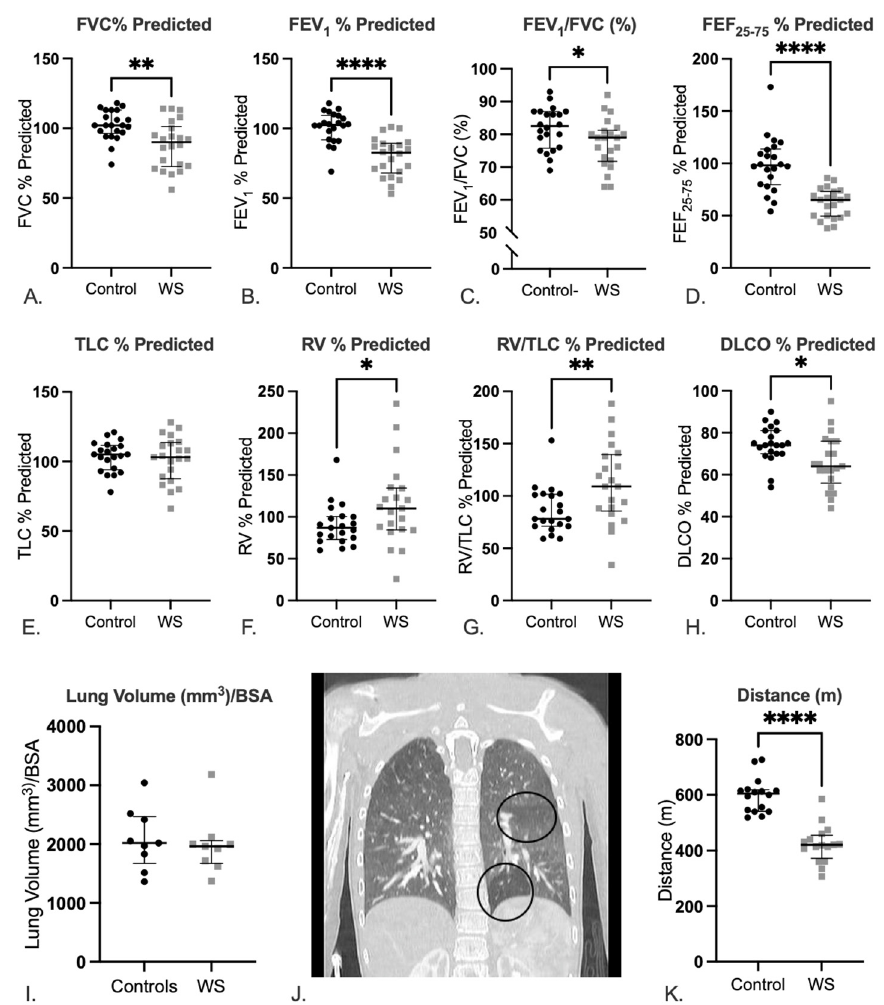
Taken as a group, people with WS exhibit lower percentage predicted values for FVC (Figure 1A, control median: 113, interquartile range (IQR): 16 vs. WS median: 101.3, IQR: 24; p = 0.002) and FEV 1 (Figure 1B, control median: 109.3, IQR: 16 vs. WS median: 89.25, IQR: 18.5; p < 0.0001) than controls, and the FEV 1 /FVC ratio is decreased in cases (Figure 1C, control median: 87.0, IQR: 10.5 vs. WS median: 81.3, IQR: 13; p = 0.04), supporting a signal for obstructive pattern on spirometry for people with the WS diagnosis. Forced expiratory flow between 25 and 75% (FEF 25–75 ) is also decreased in cases compared to controls (Figure 1D, control median: 113.8, IQR: 75 vs. WS median: 73.3, IQR: 21; p < 0.0001) further supporting airflow obstruction. There is no difference in total lung capacity (TLC, % predicted) (Figure 1E, control median: 111.3, IQR: 16.5 vs. WS median: 113.5, IQR: 25; p = NS), but residual volume (RV, % predicted) is significantly greater in those with WS as compared to controls (Figure 1F, control median: 100.3, IQR: 82.5 vs. WS median: 134.5, IQR: 125; p = 0.03). The RV/TLC ratio (% predicted) is significantly greater in WS cases (Figure 1G, control median: 101.3, IQR: 75 vs. WS median: 139.5, IQR: 79; p = 0.003), suggestive of greater air trapping. Individuals with WS showed a reduction in the diffusion capacity for carbon monoxide (DLCO) (Figure 1H, control median: 81, IQR: 16 vs. WS median: 76, IQR: 31; p = 0.01), indicating mildly decreased gas exchange.